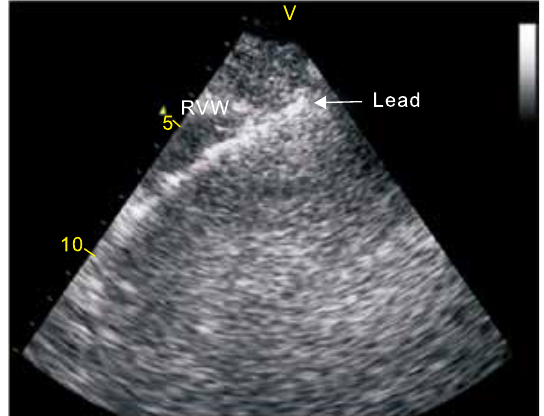
Figure 2 Two-dimensional transthoracic echocardiography in zoom mode with apical view. The arrow points to the tip of the lead crossing the apical wall of the right ventricle to the pericardial fat. RVW, right ventricular wall.